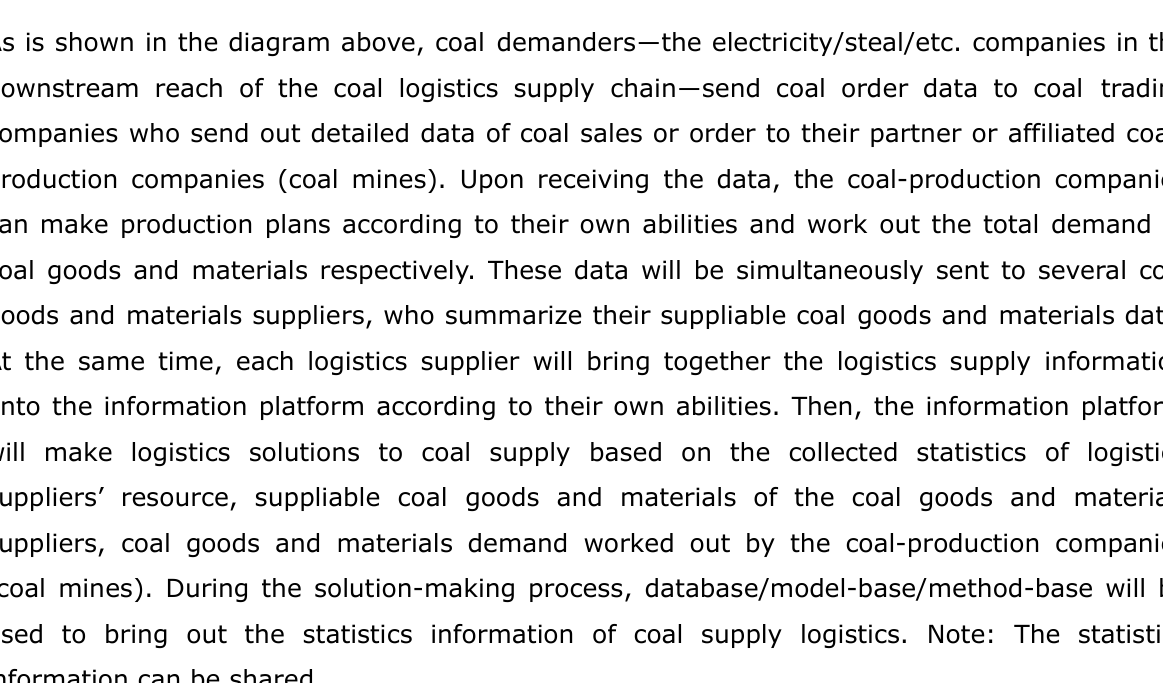
Figure 3. flow diagram of logistics information platform for coal